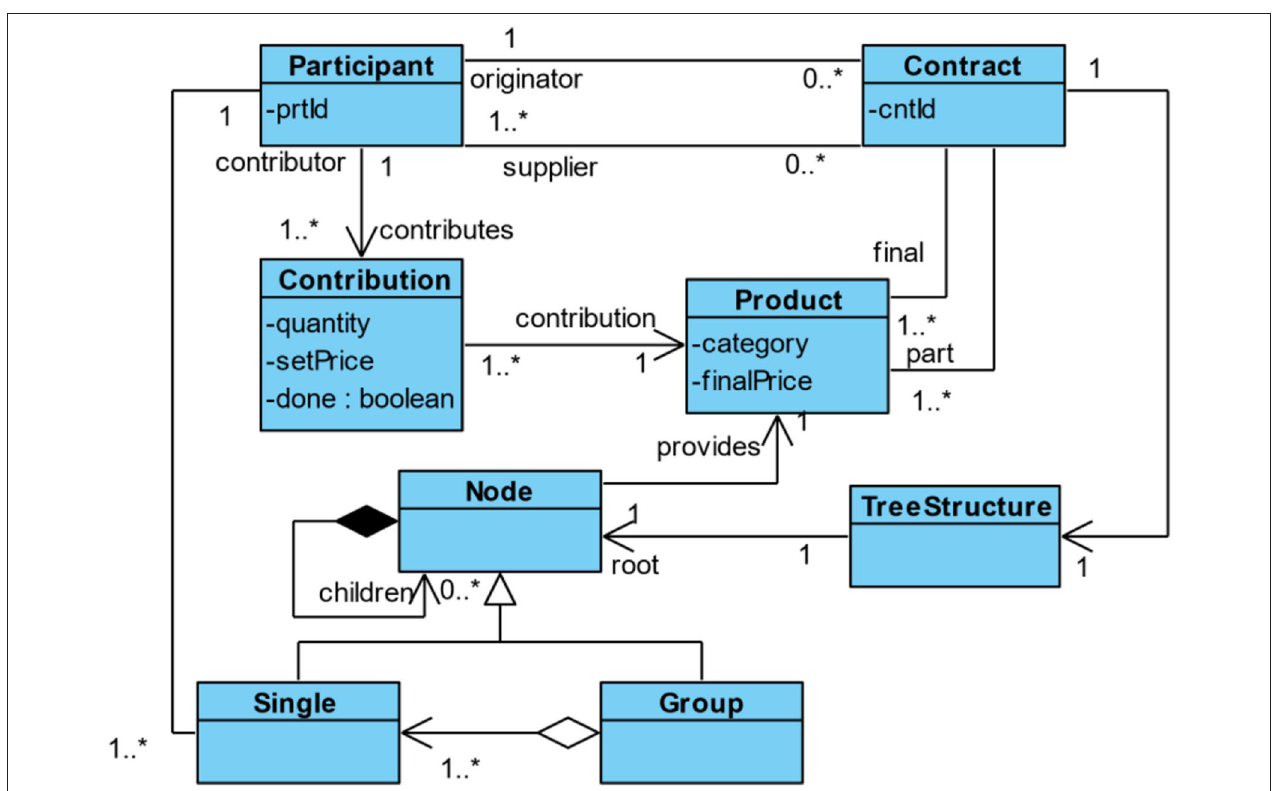
FIGURE 5 | A class diagram depicting the domain model of contracts on supply